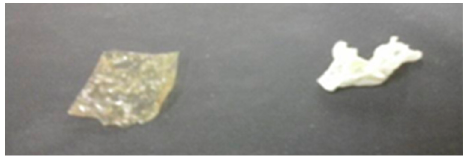
Figure 10. PVPA-Chitosan sol gel films before and after water soak testing.